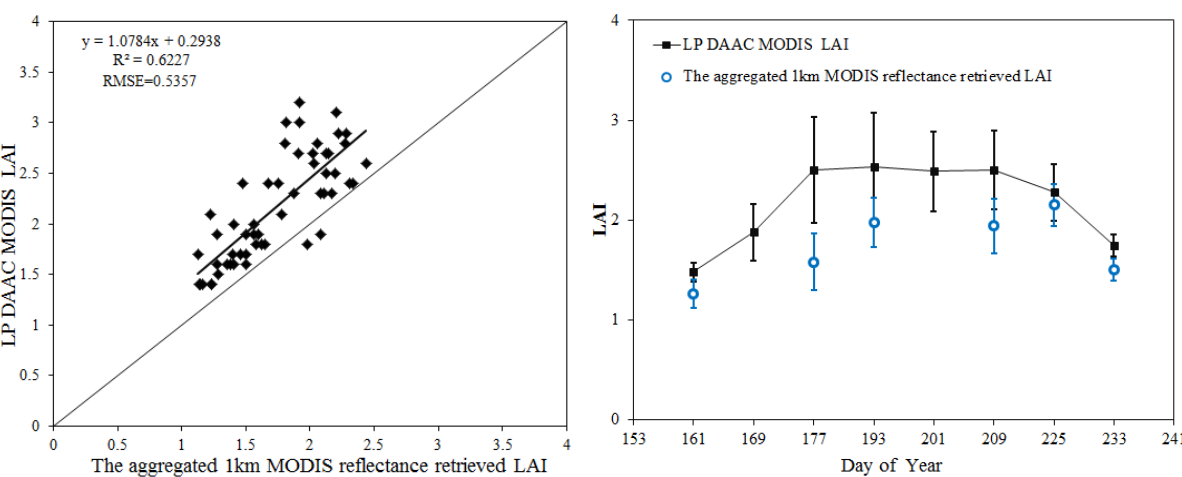
Figure 10. Comparison between the LP DAAC MODIS LAI and the aggregated 1 km MODIS reflectance retrieved LAI values at the pixel ( left ) and patch ( right ) scale. The error bars indicate the standard